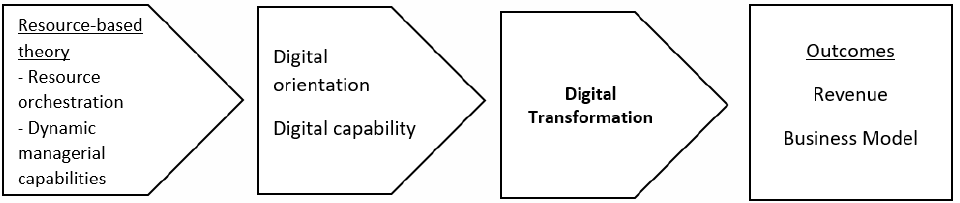
Figure 1. A framework of the impact of digital orientation and digital capability on digital transfor- mation by SME managers.